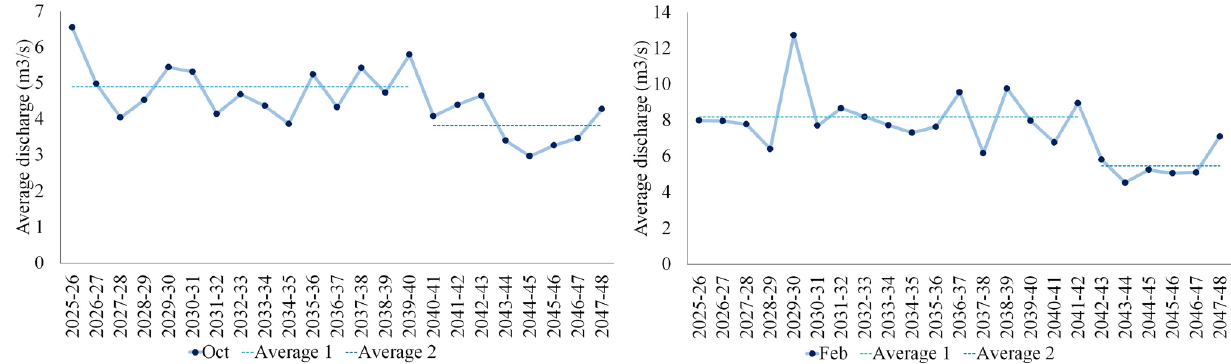
Fig. 11 Homogeneity test for the long-term mean streamflow in the future period under the scenario RCP4.5